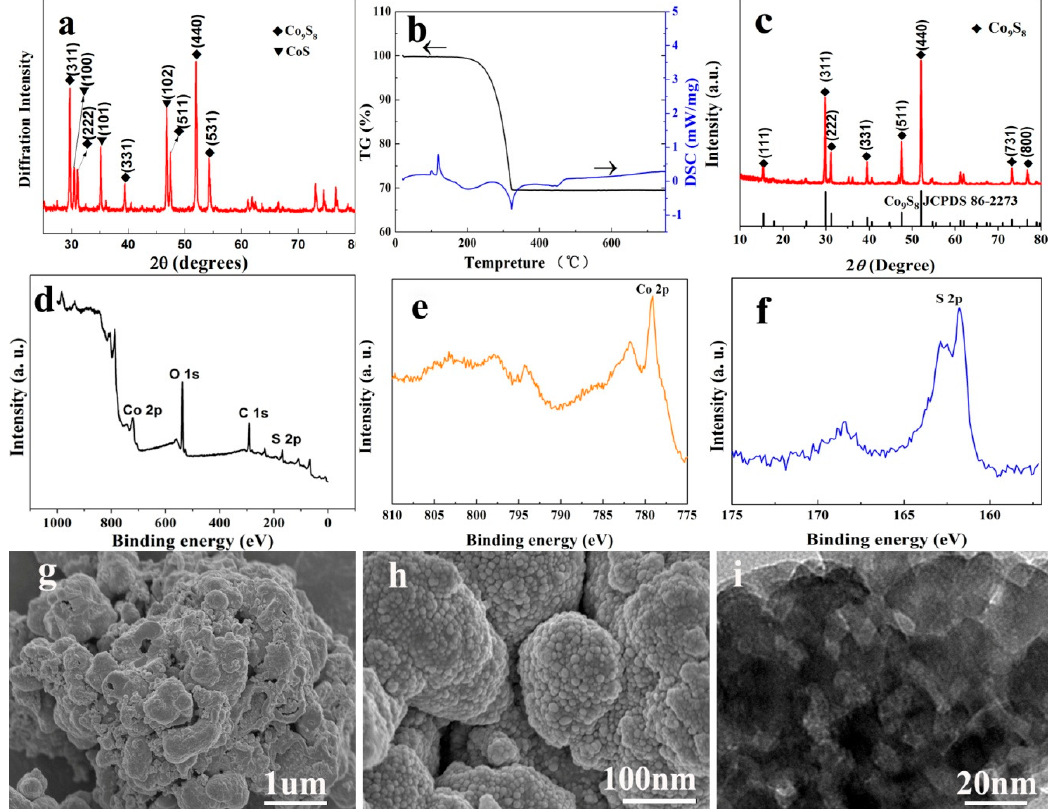
Figure 1. ( a ) XRD pattern and ( b ) DSC ‐ TGA curve of the Co 9 S 8 precursor. ( c ) XRD pattern of Co 9 S 8 . ( d ) Overall XPS, ( e ) Co 2p, and ( f ) S 2p XPS spectra of Co 9 S 8 . ( g ) SEM image of Co 9 S 8 precursor. ( h ) SEM image and ( i ) TEM image of the Co 9 S 8 .